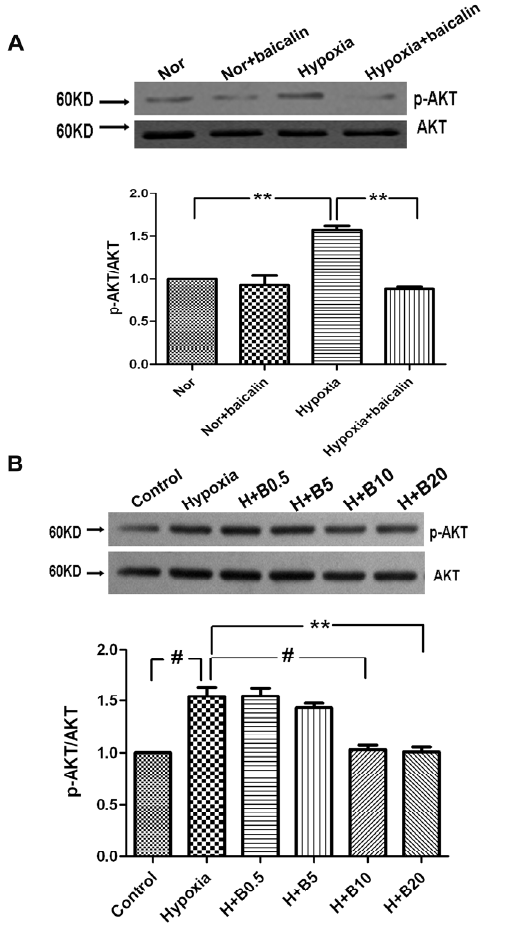
Figure 3. The effects of baicalin on p-AKT expression in rat lungs and cultured rat PASMCs. ( A ) Representative western blotting analysis of p-AKT protein levels in rat lungs; ( B ) Representative western blotting analysis of p-AKT protein levels in cultured rat PASMCs. “Nor” means normoxia; “H” means hypoxia; “B” means baicalin. ( # p < 0.001; ** p < 0.01). All values are denoted as the mean ± SEM from at least three separate